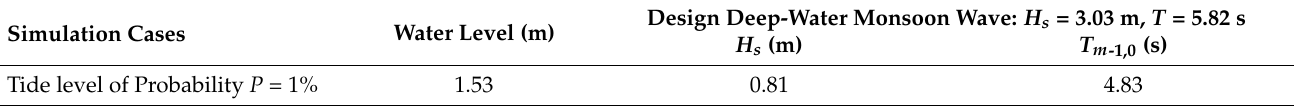
Table 1. Design wave for the structure prototype location.